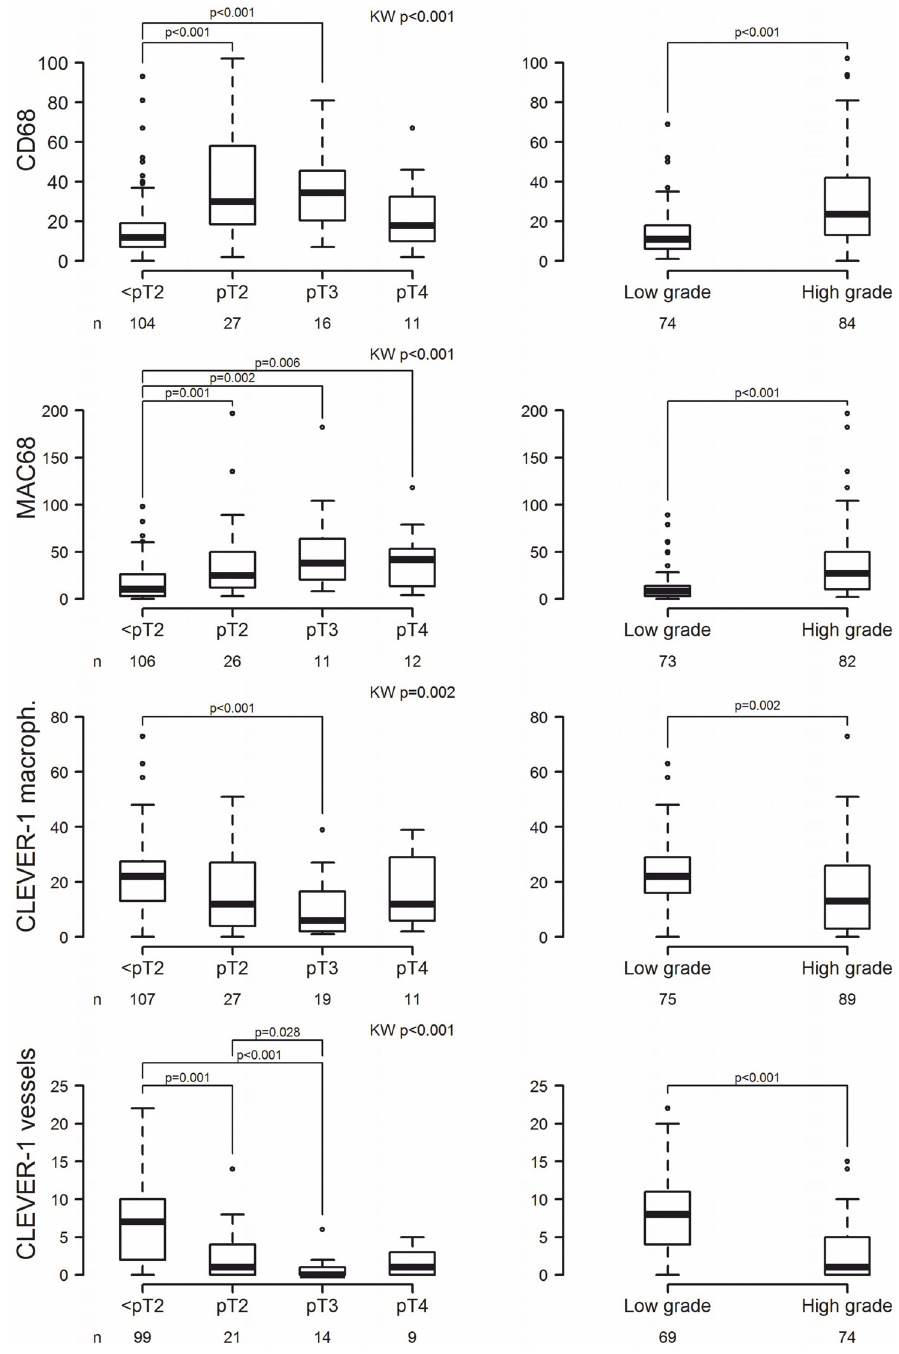
Fig 2. Group differences between pT category and tumor grade and CD68, MAC387, and CLEVER-1 expression. The Mann-Whitney U test was used for pair-wise comparisons in analyses of tumor grade and Kruskal-Wallis rank-sum testing (KW) was used for comparison across the four pT categories. The bottom and top edges of the box indicate the intra-quartile range (IQR), the line inside the box indicates the median value, the whiskers that extend from each box indicate the range of values that are outside of the intra- quartile range but closer than or equal to 1.5 times the IQR, and any points that are at a distance of more than 1.5 times the IQR from the box are considered to be outliers [circles indicate the mild outliers (more than 1.5 times the IQR), and asterisks extreme outliers (more than 3 times the